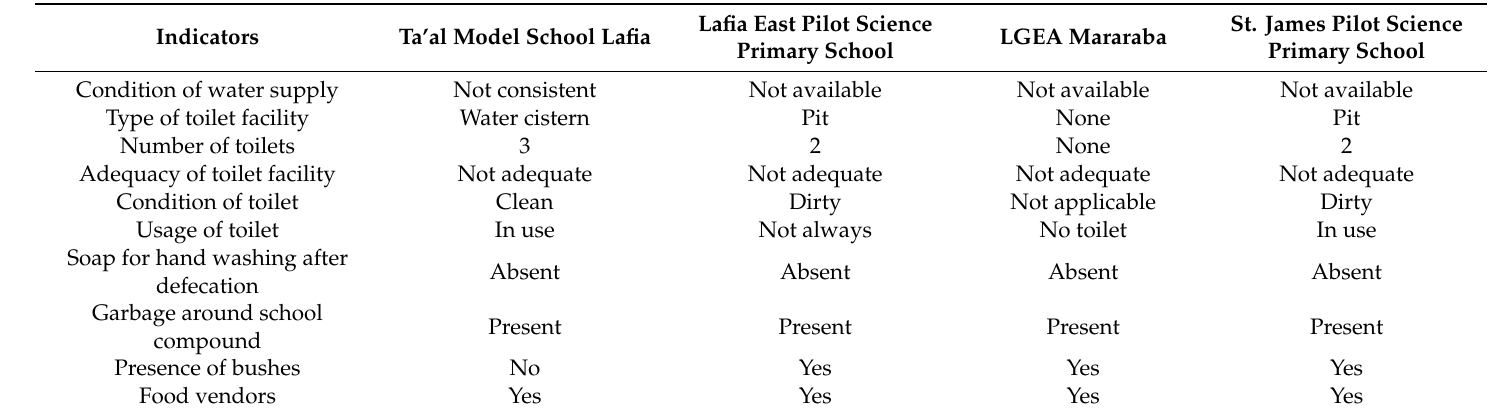
Table 4. Description of the hygiene condition indicators in the four